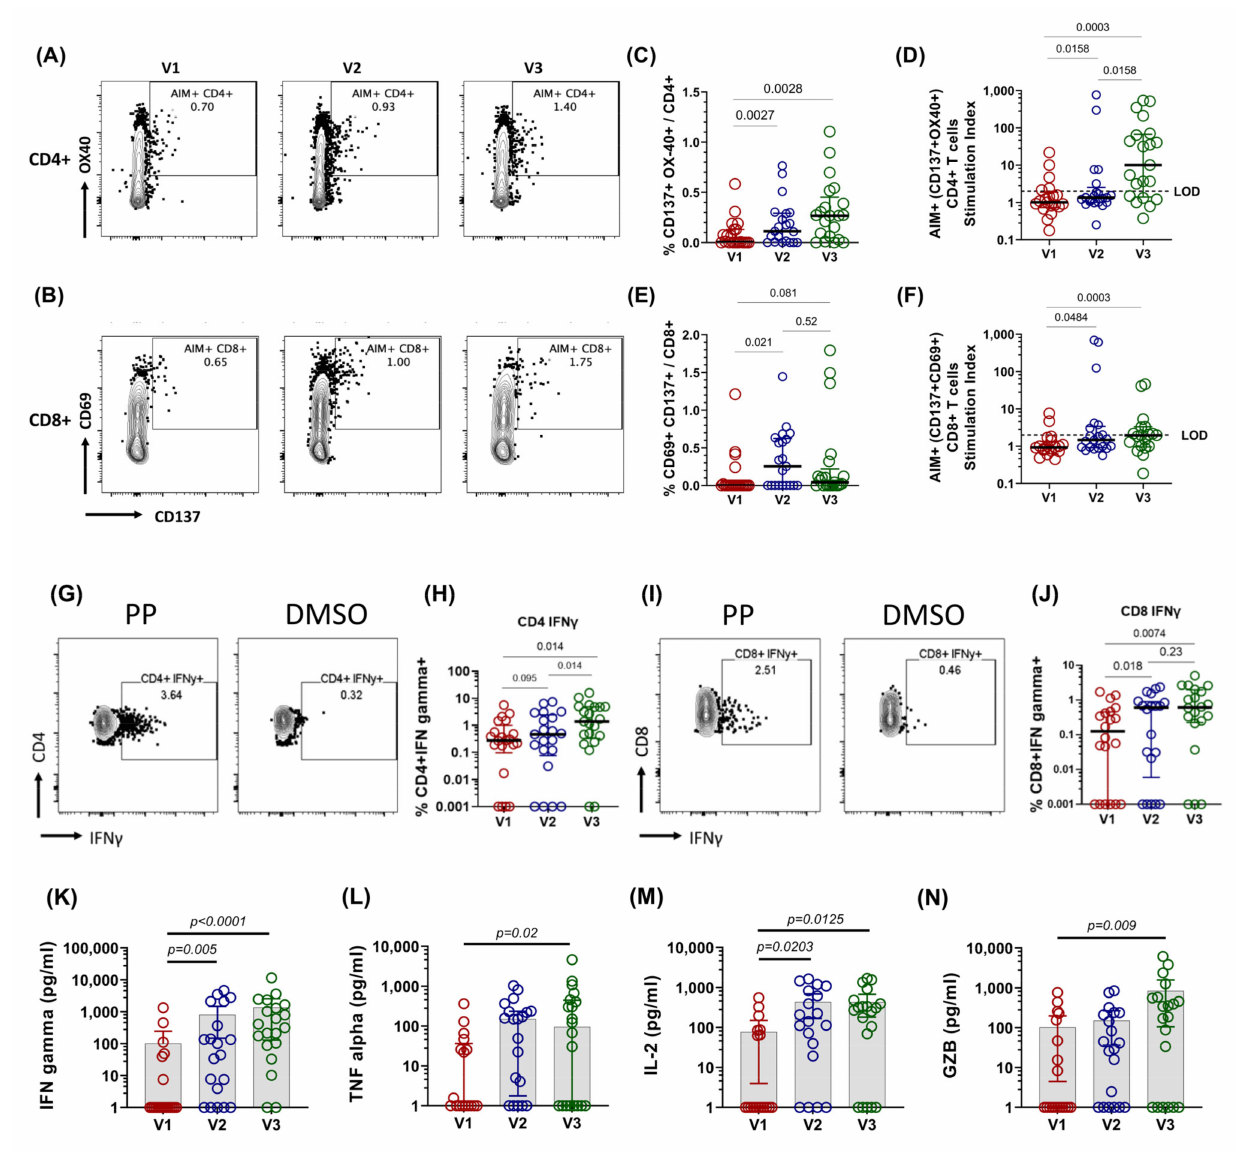
Figure 2. Longitudinal dynamics of antigen-specific T cell immune responses during COVID- 19 infection. Representative flow cytometry plots of SARS-CoV-2 spike-specific T cells express- ing activation-induced markers (AIM) ( A ) CD4+ (CD137 + OX40+), ( B ) CD8+ (CD137 + CD69+). ( C – F ) Longitudinal analysis of the AIM response in paired samples from the same subject. ( C ) Percent- age frequency of CD4+ AIM+ cells. ( D ) Stimulation index (SI) of CD4+ AIM+ cells. ( E ) %frequency of CD8+ AIM+ cells ( F ) SI of CD8+ AIM+ cells. ( G , I ) Representative flow cytometry plots for the intracellular cytokine staining (ICS) assay of cells upon stimulation with spike peptide pool, com- pared to the DMSO. Longitudinal analysis of the frequency (percentage of total CD4+ or CD8+ cells) of IFN- γ + cells in paired samples from the same subject. ( H ) CD4+ interferon gamma (IFN γ ). ( J ) CD8+ interferon gamma. Each datapoint shown is background-subtracted (DMSO stimulated wells), and line represents median values for each time point. Two-sided Wilcoxon signed rank tests were employed for paired non-parametric analysis. LOD = limit of detection for AIM assay was SI < 2. ( K – N ) Longitudinal dynamics of antigen-specific cytokine release by PBMCs during COVID-19 infection. ( K ) IFN γ ; ( L ) TNF α ; ( M ) IL-2; ( N ) granzyme B. Graphs represent longitudinal cytokine released (background-subtracted) by paired PBMC samples from the same subject upon stimulation with SARS-CoV-2 spike peptide pool for 22–24 h. Bars represent median values with